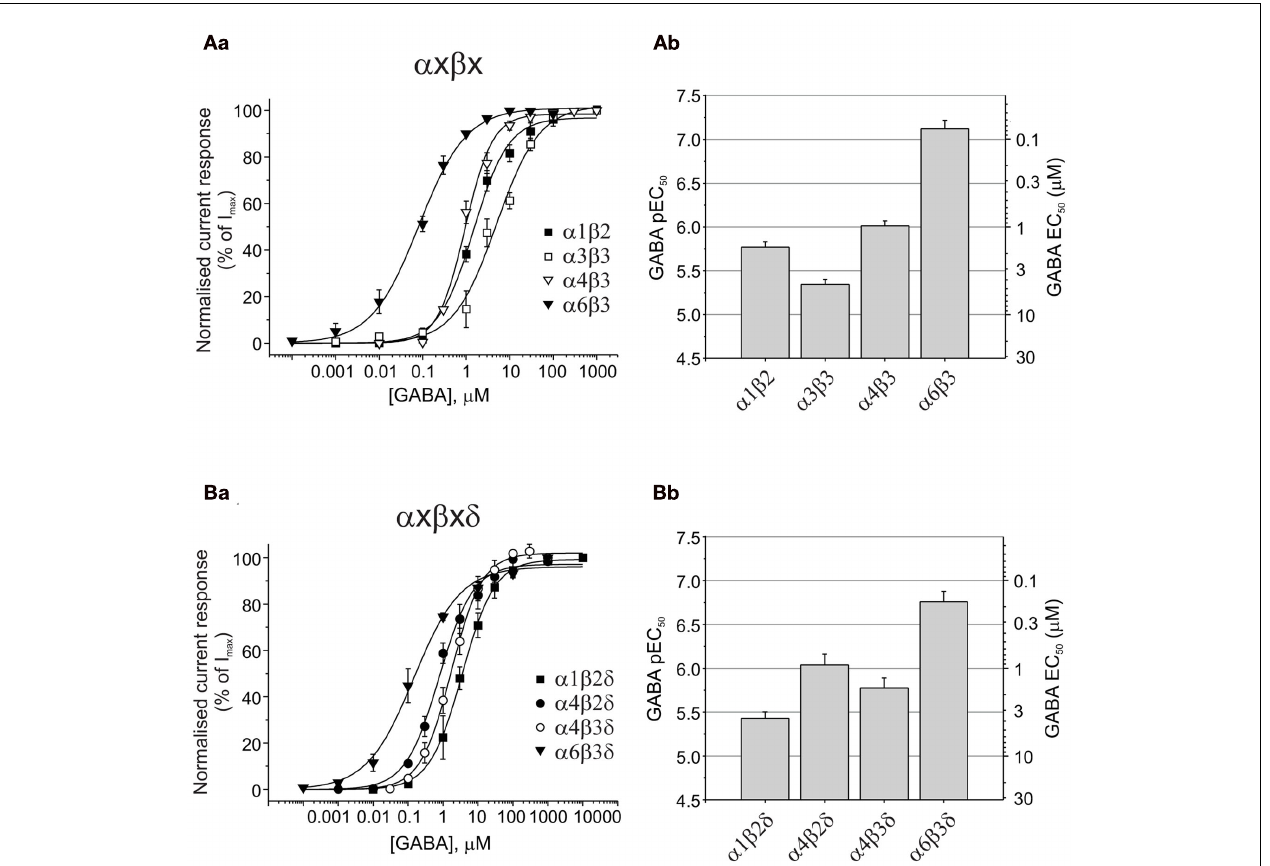
FIGURE 3 | GABA potencies at αβ and αβδ GABA A receptors. (Aa) GABA concentration response curves for α 1 β 2, α 3 β 3, α 4 β 3, and α 6 β 3 ( n = 20). (Ab) Bar chart of pEC 50 (mean ± SEM) and equivalent EC 50 values for αβ receptors.